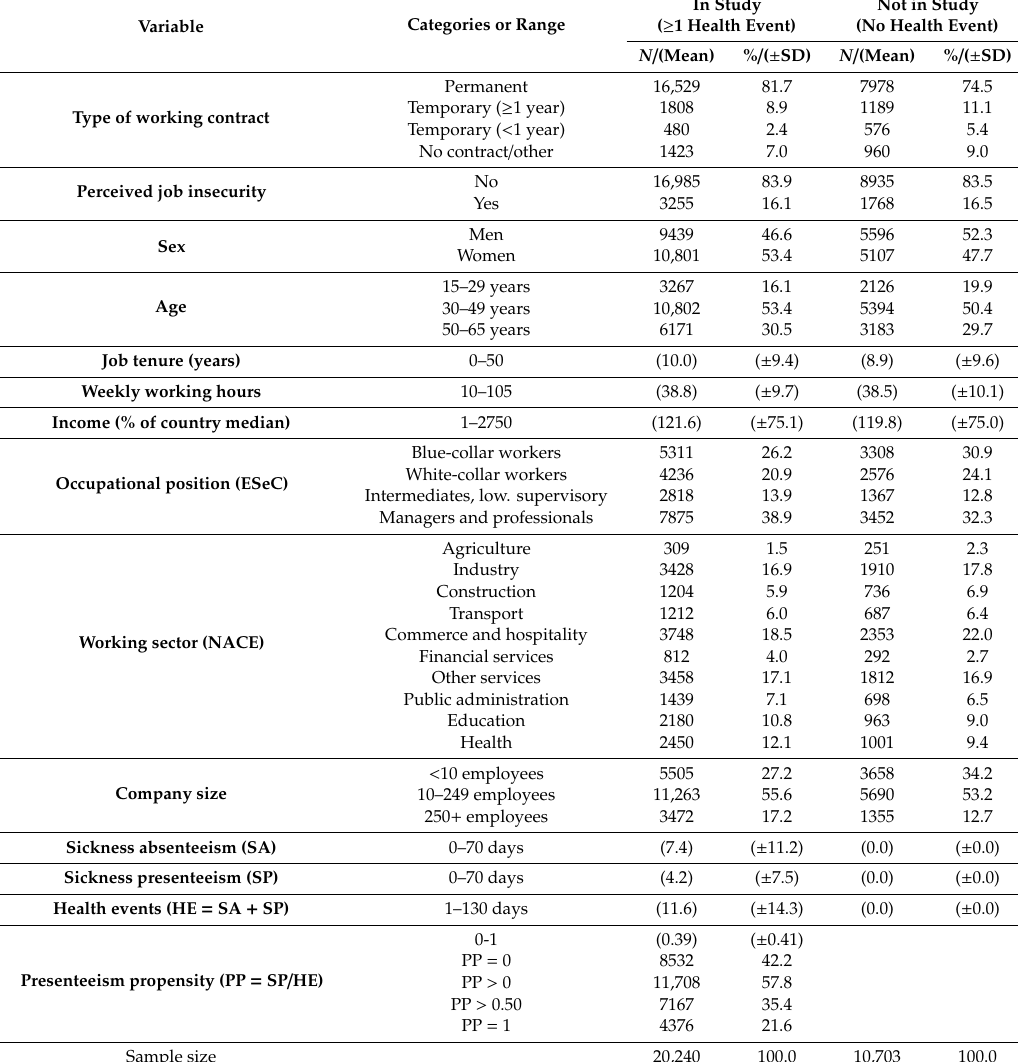
Table 1. Study population by socio-demographic, occupational and health-related